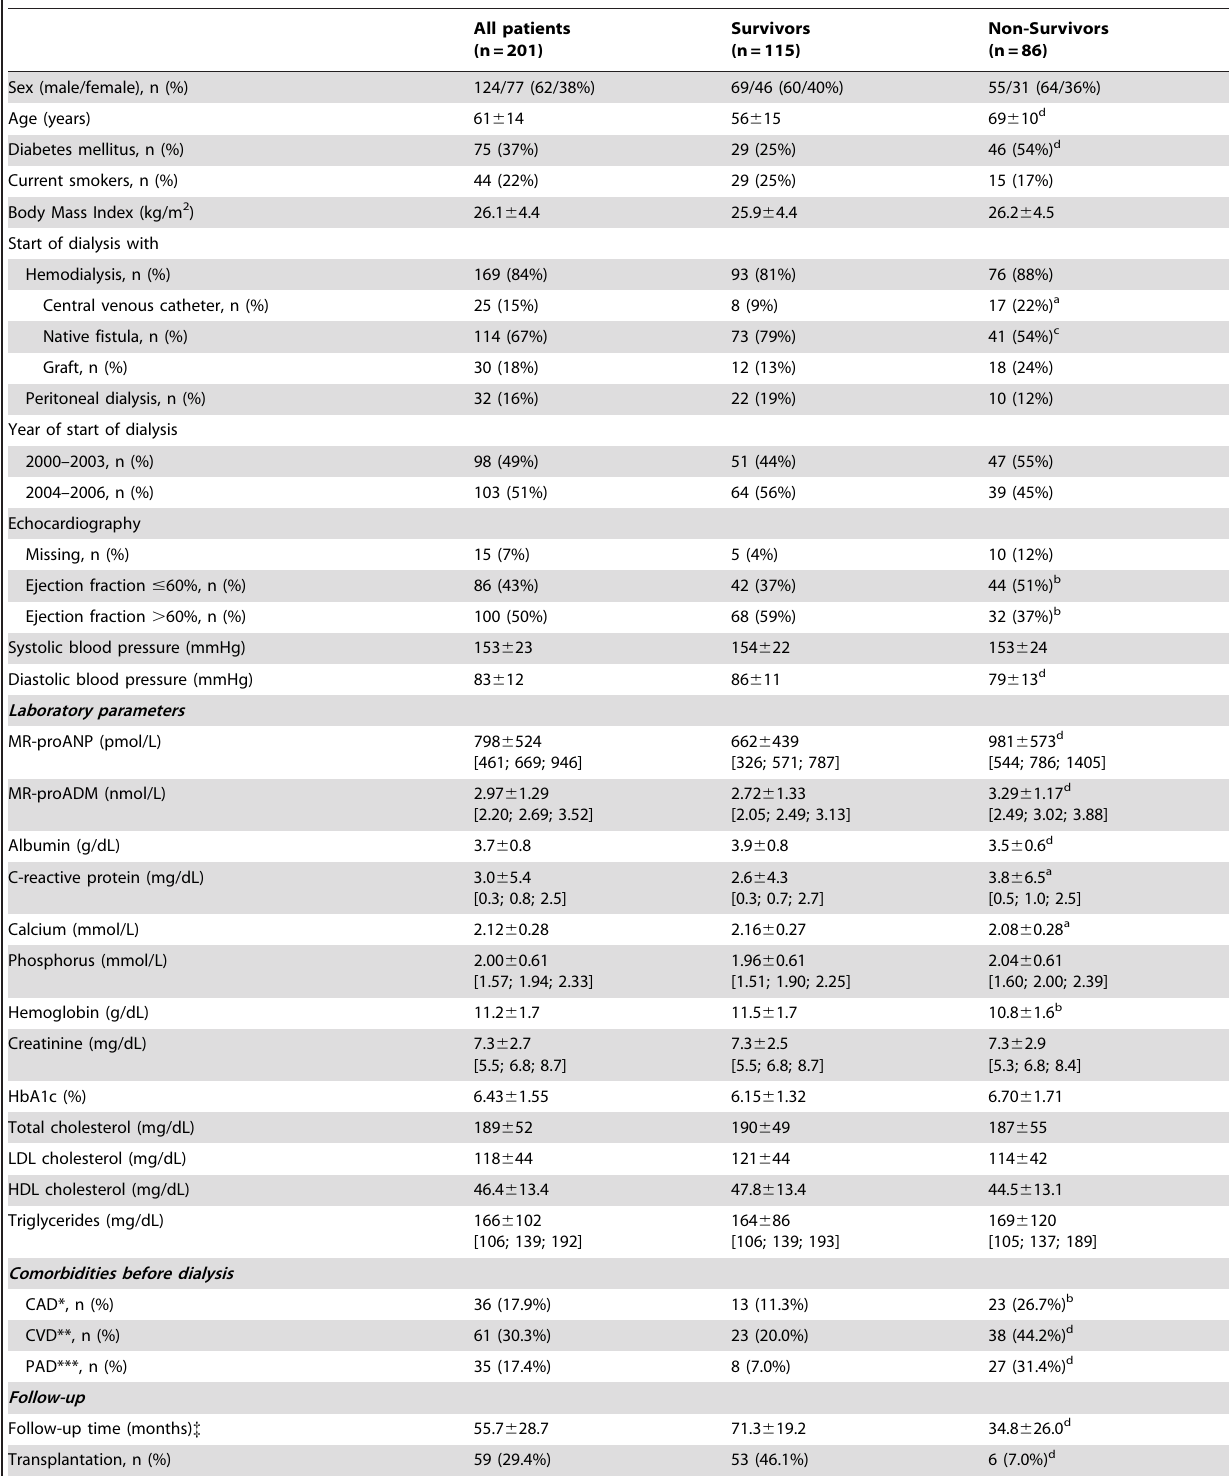
Table 1. Clinical characteristics of patients.